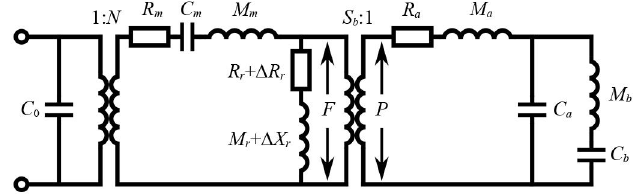
Figure 2. Equivalent circuit.